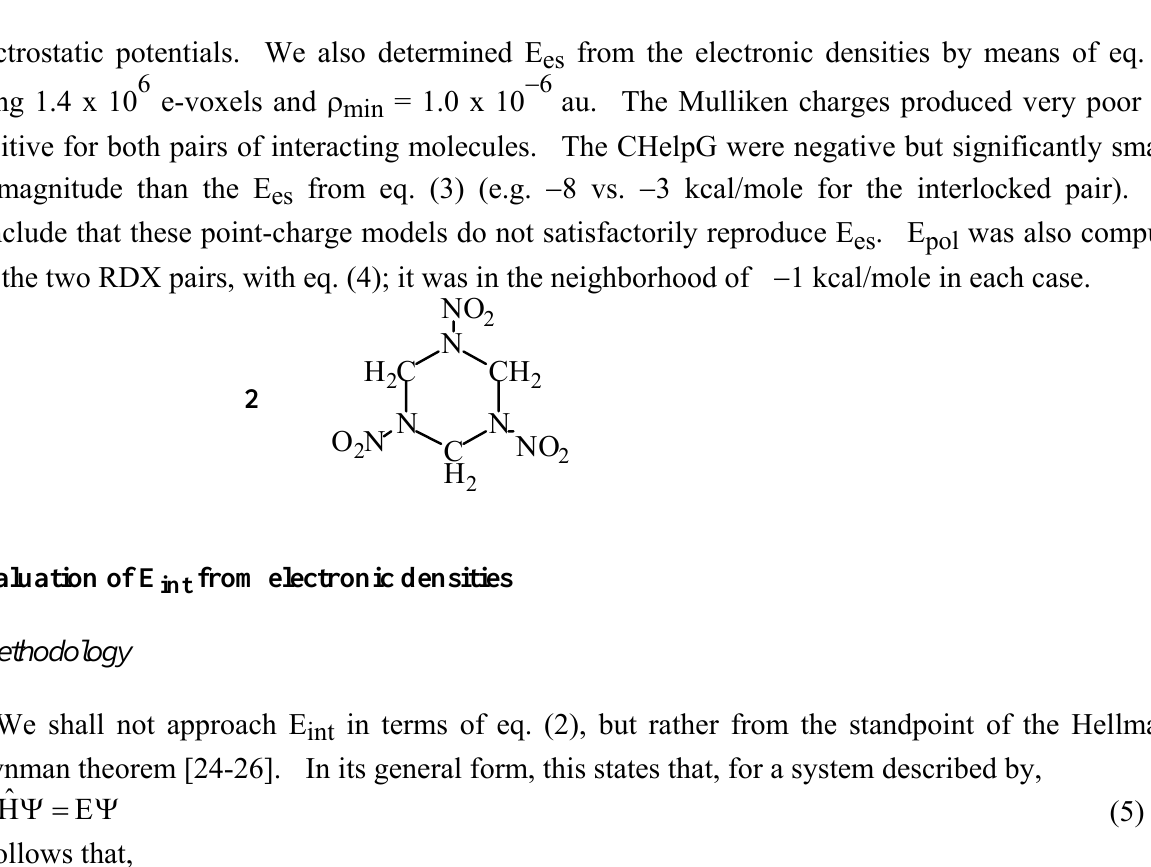
Table 1. Electrostatic interaction energies E es , in kcal/mole, for two uracil dimers. Uracil molecular geometry taken from MP2/TZ2P(f,d)++ optimized dimer structures. stepsize is 0.0860 A, and condensation number n = 5.